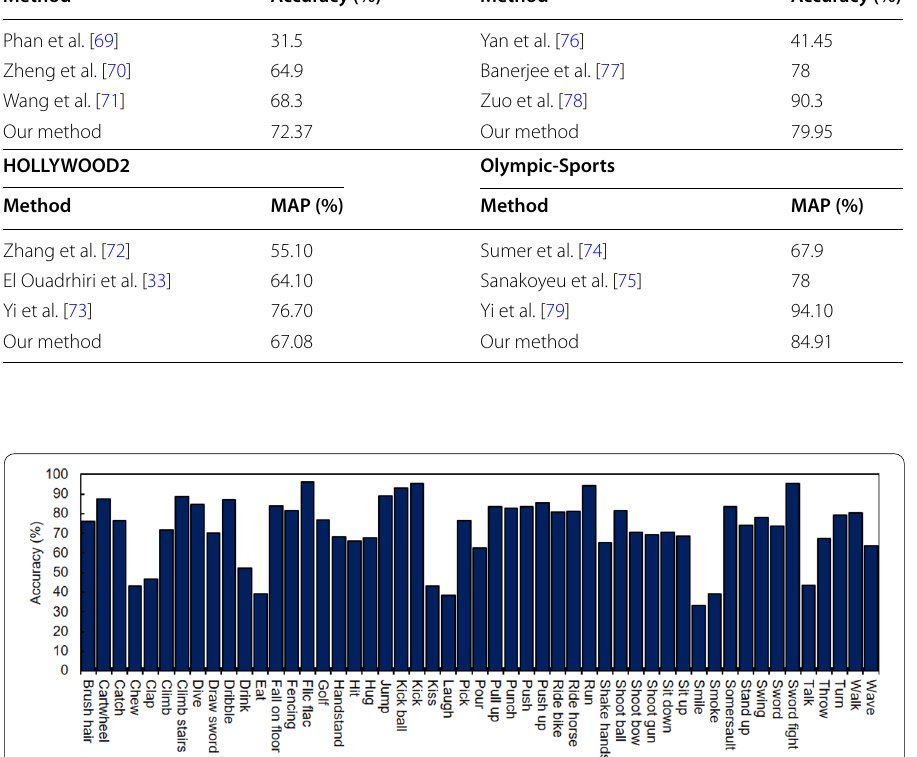
Fig. 11 The detailed accuracy by class for the HMDB51